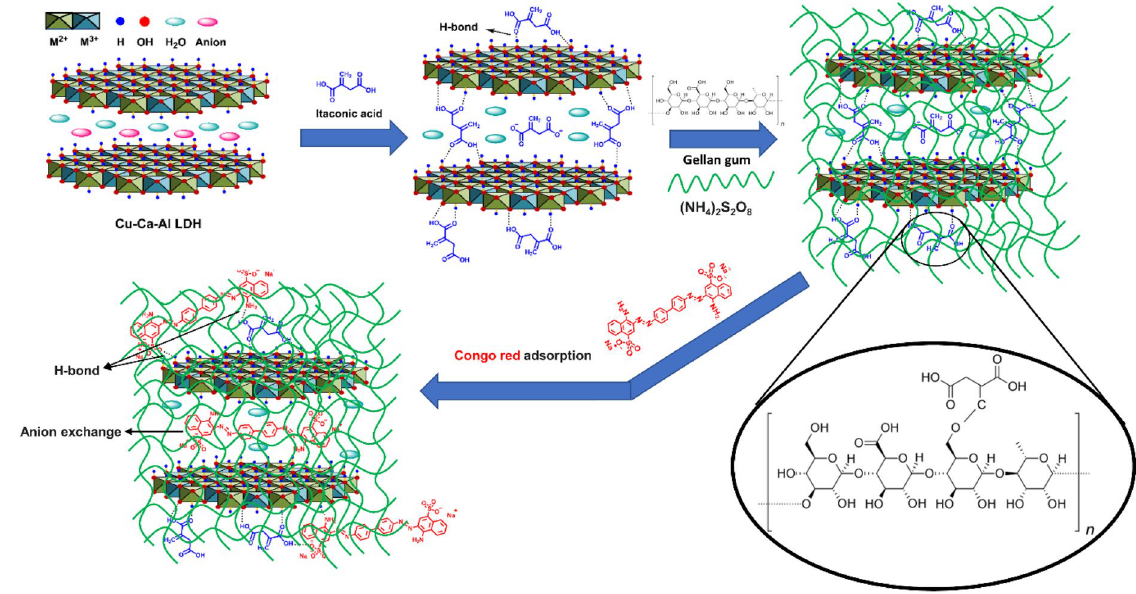
Figure 1. The schematic representation for the structure of the prepared adsorbents and their application for adsorption of CR from aqueous